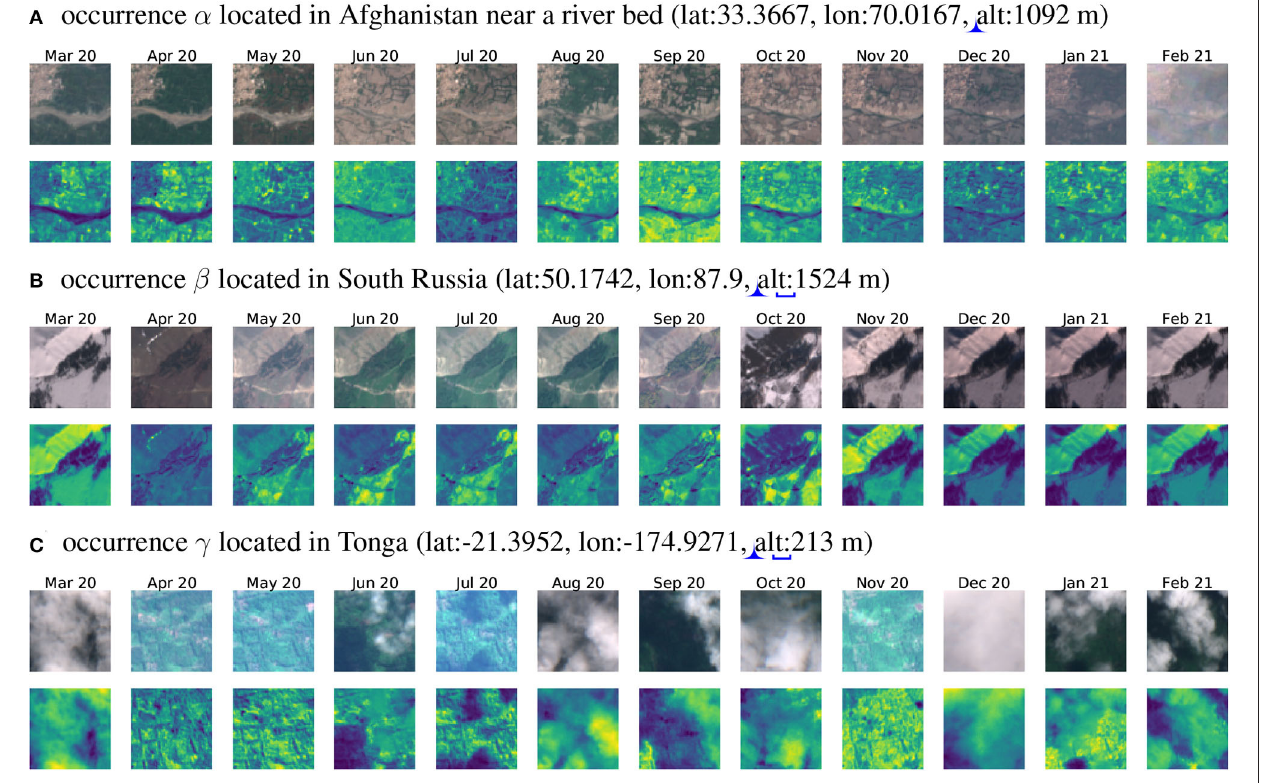
FIGURE 5 | Image time series associated with the three occurrences located in Figure 4C map. RGB images are shown on the first line and IR patches on the second. (A) is almost cloud-free and globally normalized before visualization (i.e., all months are divided by TS maximum pixel), (B) is a cloudless time series with a strong environmental gradient because of snow presence and is normalized by frame (i.e., each month data is divided by month maximum pixel, only for visualization), (C) is an especially cloudy time series also normalized by frame.